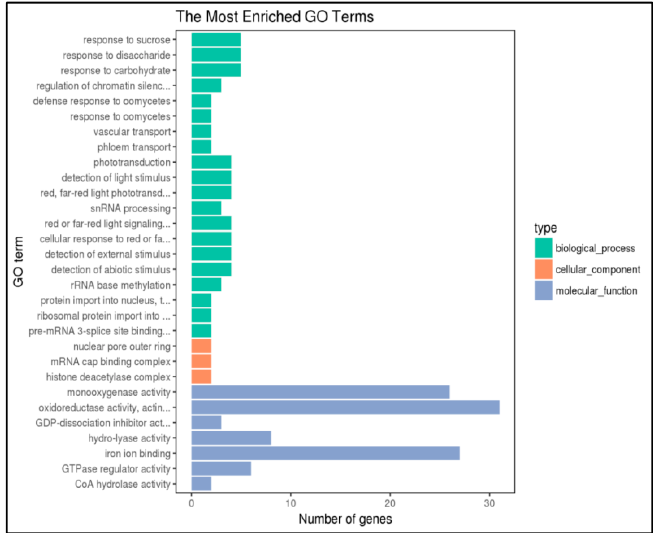
Figure 4. GO functional enrichment of differentially methylated genes in promoter regions of P427.